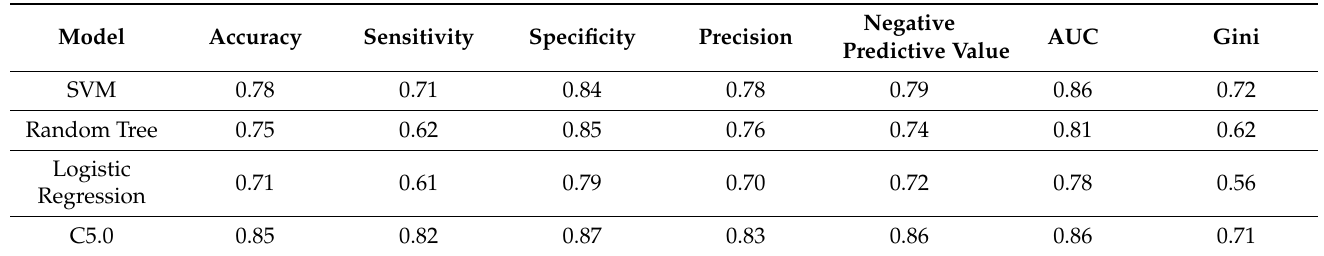
Table 4. Results of the classification performance of different machine-learning models using the cogitative reading dataset. Model